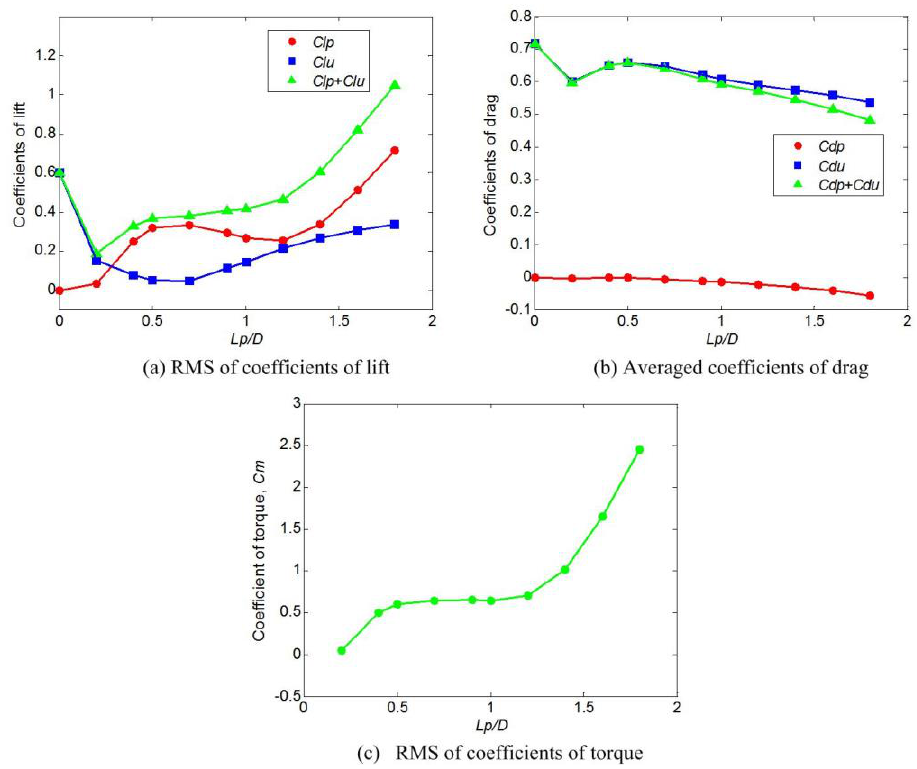
Figure 15. Effects of plate length on ( a ) lift, ( b ) drag, and ( c ) torque.